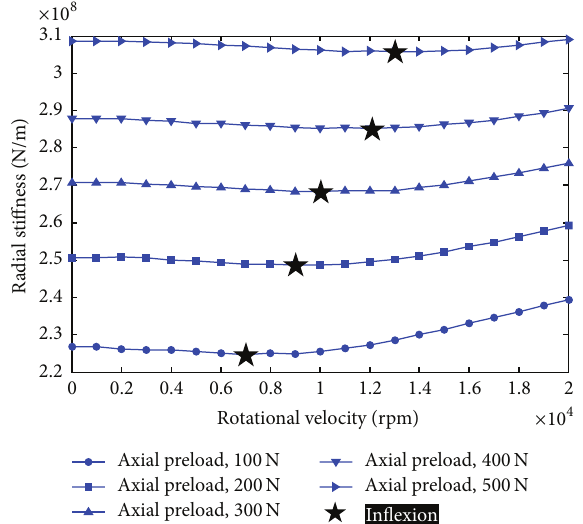
Figure 17: Radial operational stiffness of bearing versus various